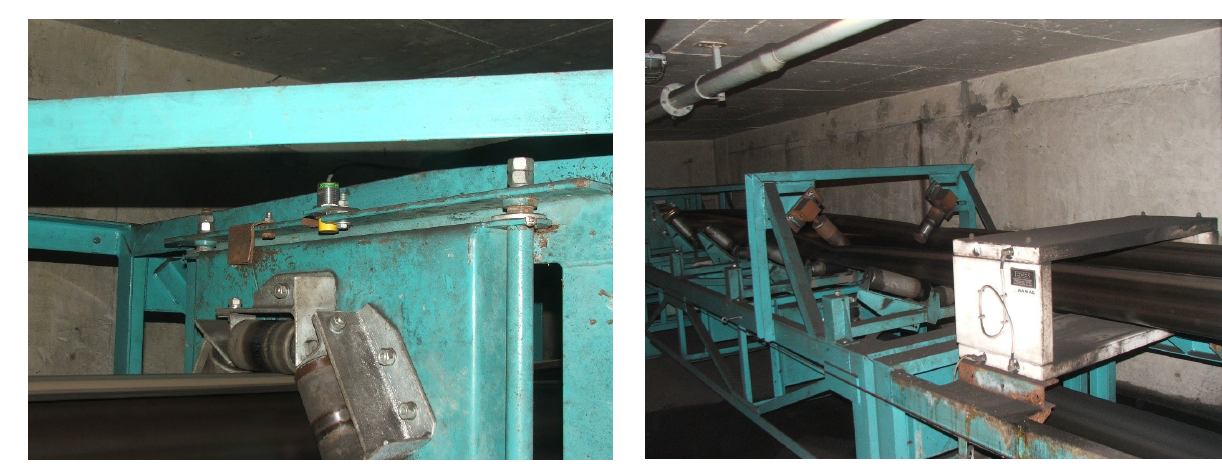
Figure 1: Material flow monitor with vertical opening [8]